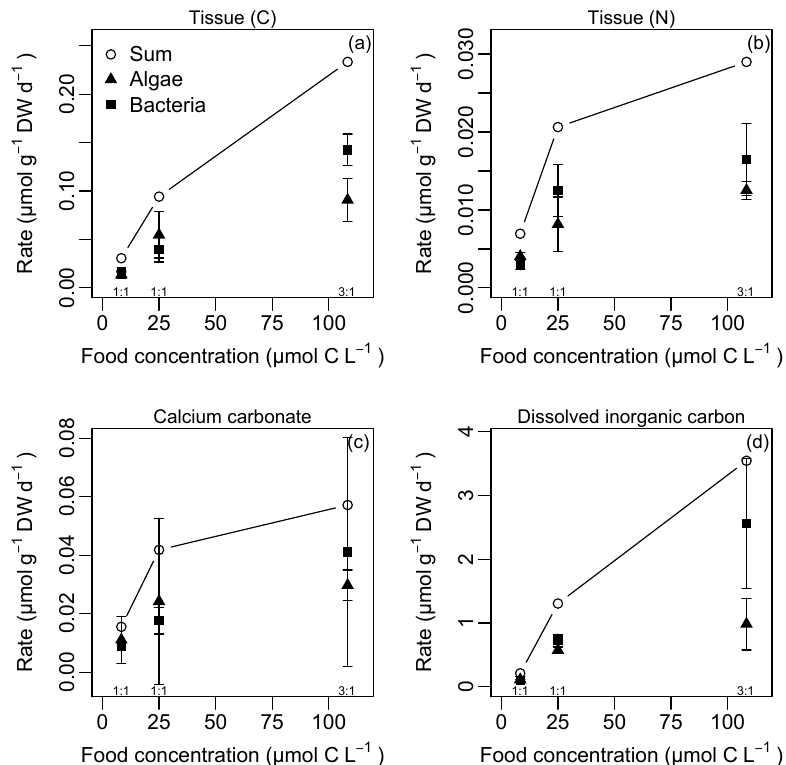
Figure 2. Food processing by the cold-water coral L. pertusa at different food concentrations and compositions. (a) Carbon assimilation in tissue, (b) nitrogen assimilation in tissue, (c) carbon incorporation into coral skeleton, (d) carbon respiration. The mean ± range is shown for the low food concentration treatment ( n = 2). The ratios 1 : 1 and 3 : 1 in the sub-panels indicate the ratio of bacteria:algae in the respective food concentration